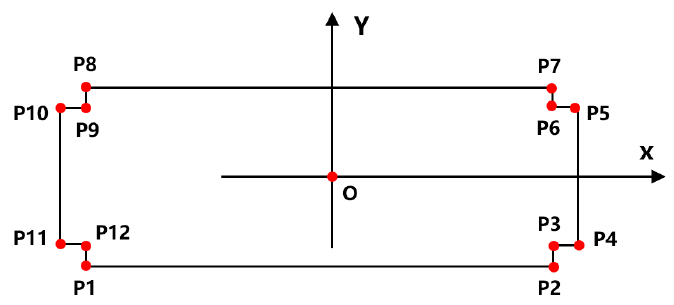
Figure 12. Example of profile definition by entity IfcArbitraryClosedProfileDef .